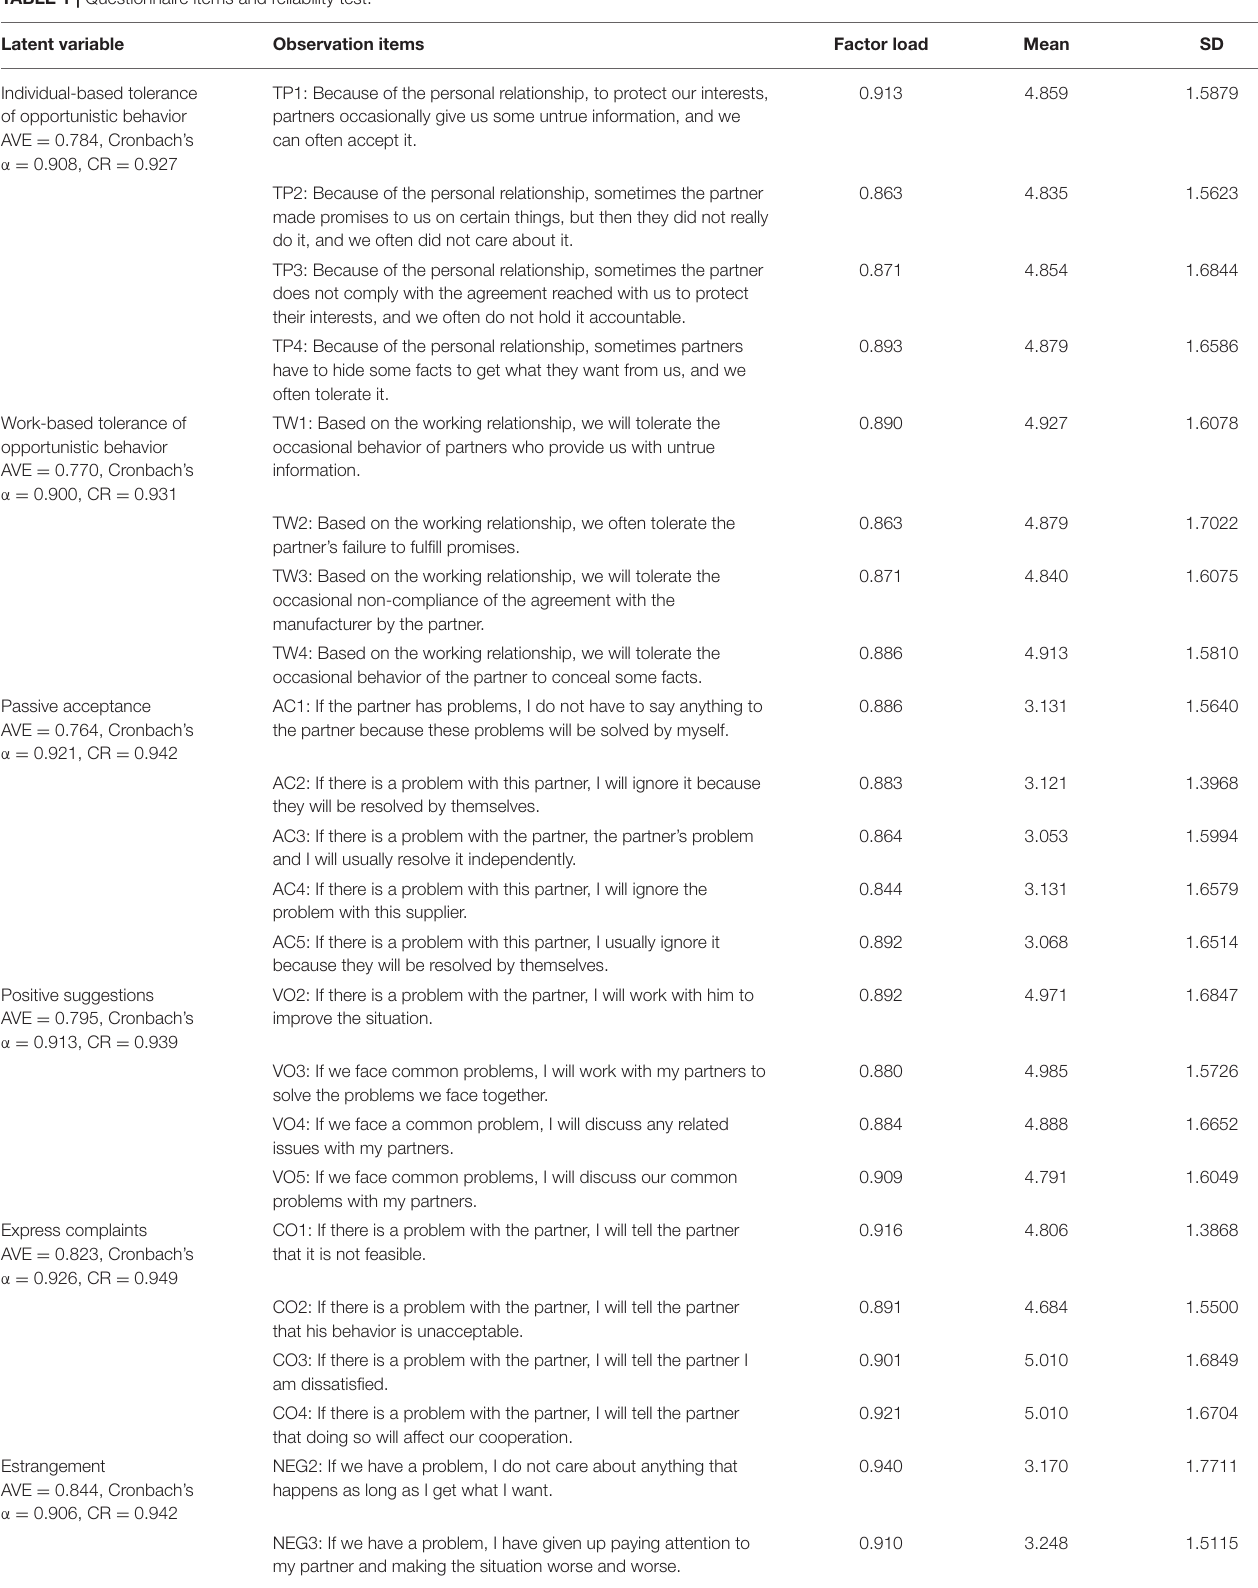
TABLE 1 | Questionnaire items and reliability test. Latent variable Observation items Factor load Mean SD Individual-based tolerance of opportunistic